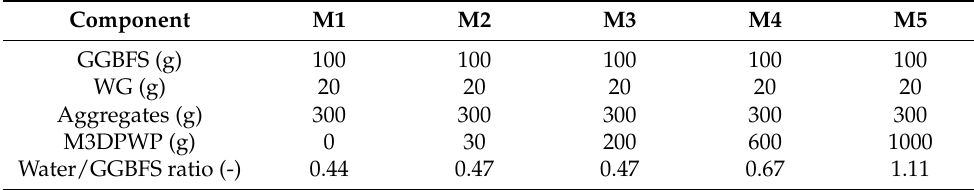
Table 3. Composition of